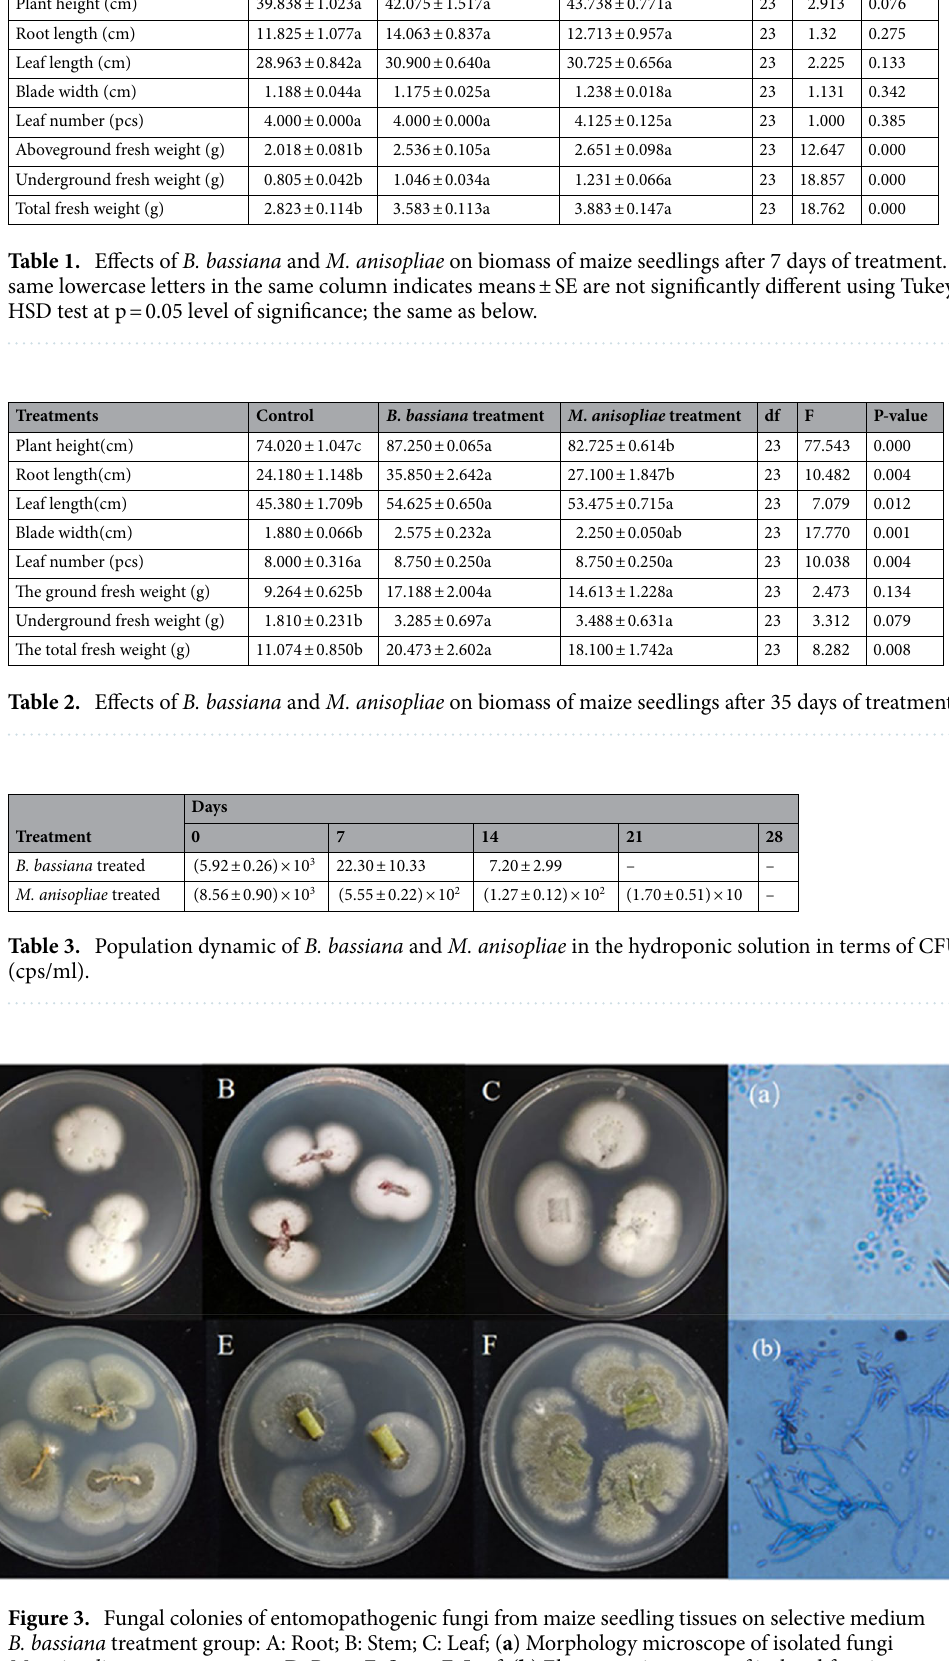
Figure 3. Fungal colonies of entomopathogenic fungi from maize seedling tissues on selective medium B. bassiana treatment group: A: Root; B: Stem; C: Leaf; ( a ) Morphology microscope of isolated fungi M. anisopliae treatment group: D: Root; E: Stem; F: Leaf; ( b ) Electron microscope of isolated